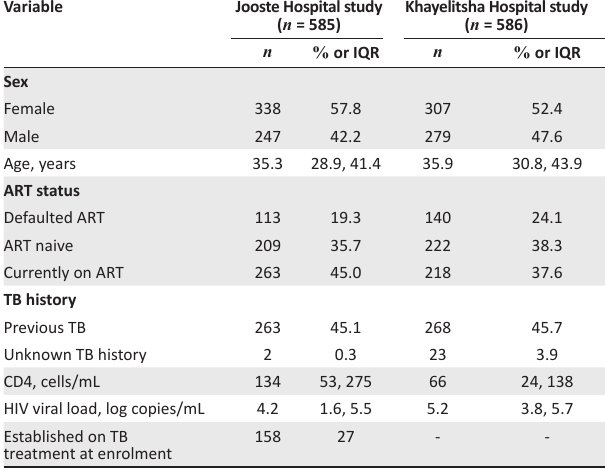
TABLE 1: Baseline characteristics of Jooste Hospital tuberculosis study and Khayelitsha Hospital tuberculosis study